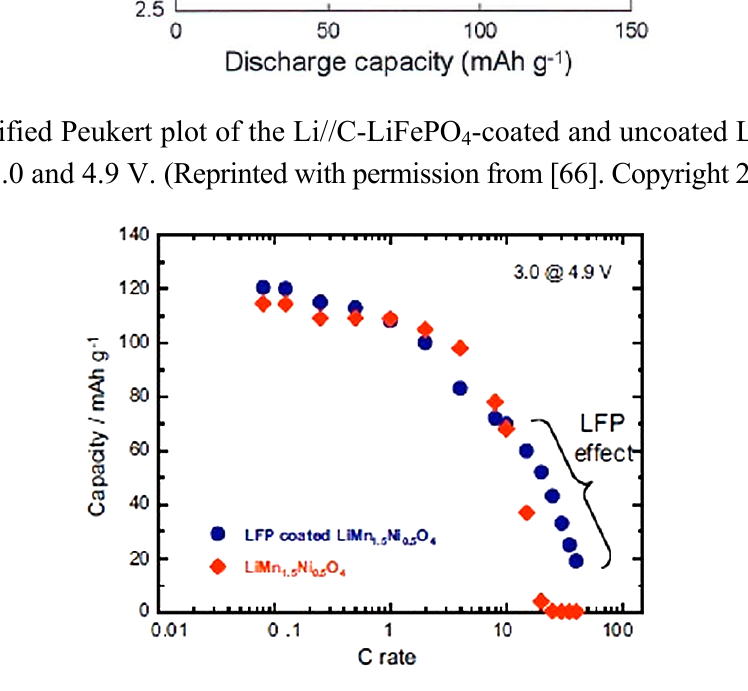
-coated and uncoated LiMn 4